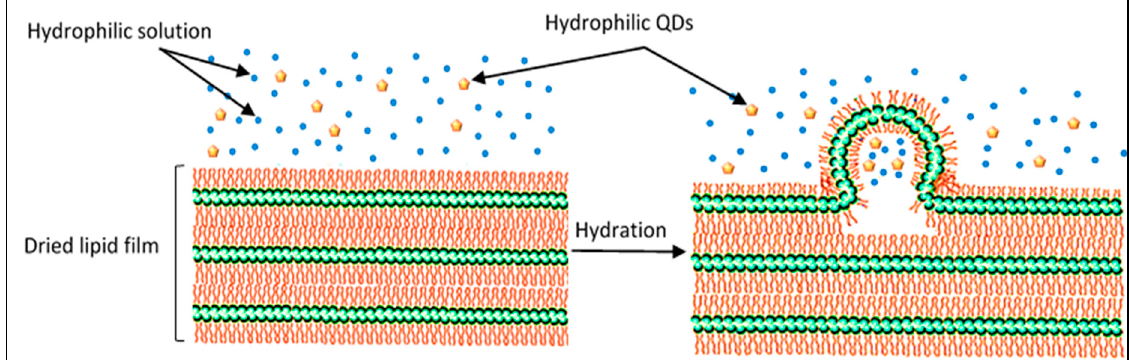
Figure 1. Scheme of the hydration of the dried lipid film and liposome formation. During this process, hydrophilic solutions and QDs are encapsulated inside the core of the formed liposomes.